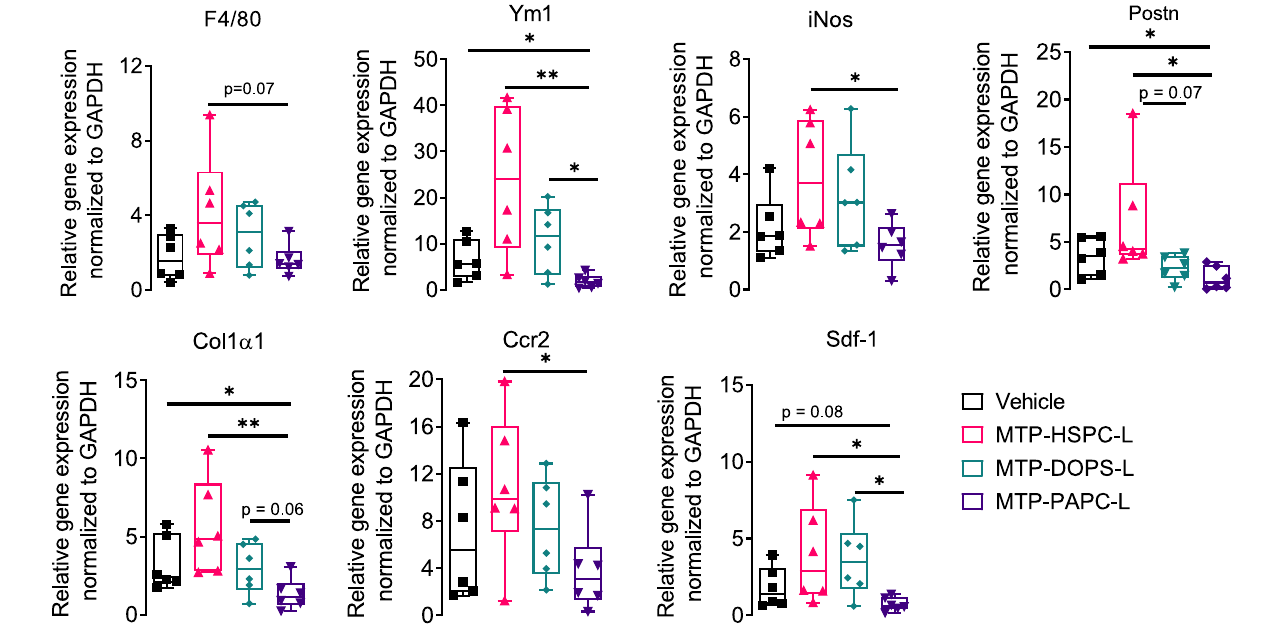
represent the box-and-whisker plots where every dot represents a data point and the line in the boxcorrespondstothemedian. The boxes go fromtheuppertothe lower quartiles, and the whiskers go from the minimum to the maximum value. Statisticalanalysiswasperformed with unpaired two-tailed Student ’ s t -test.Source data are provided as a Source Data fi